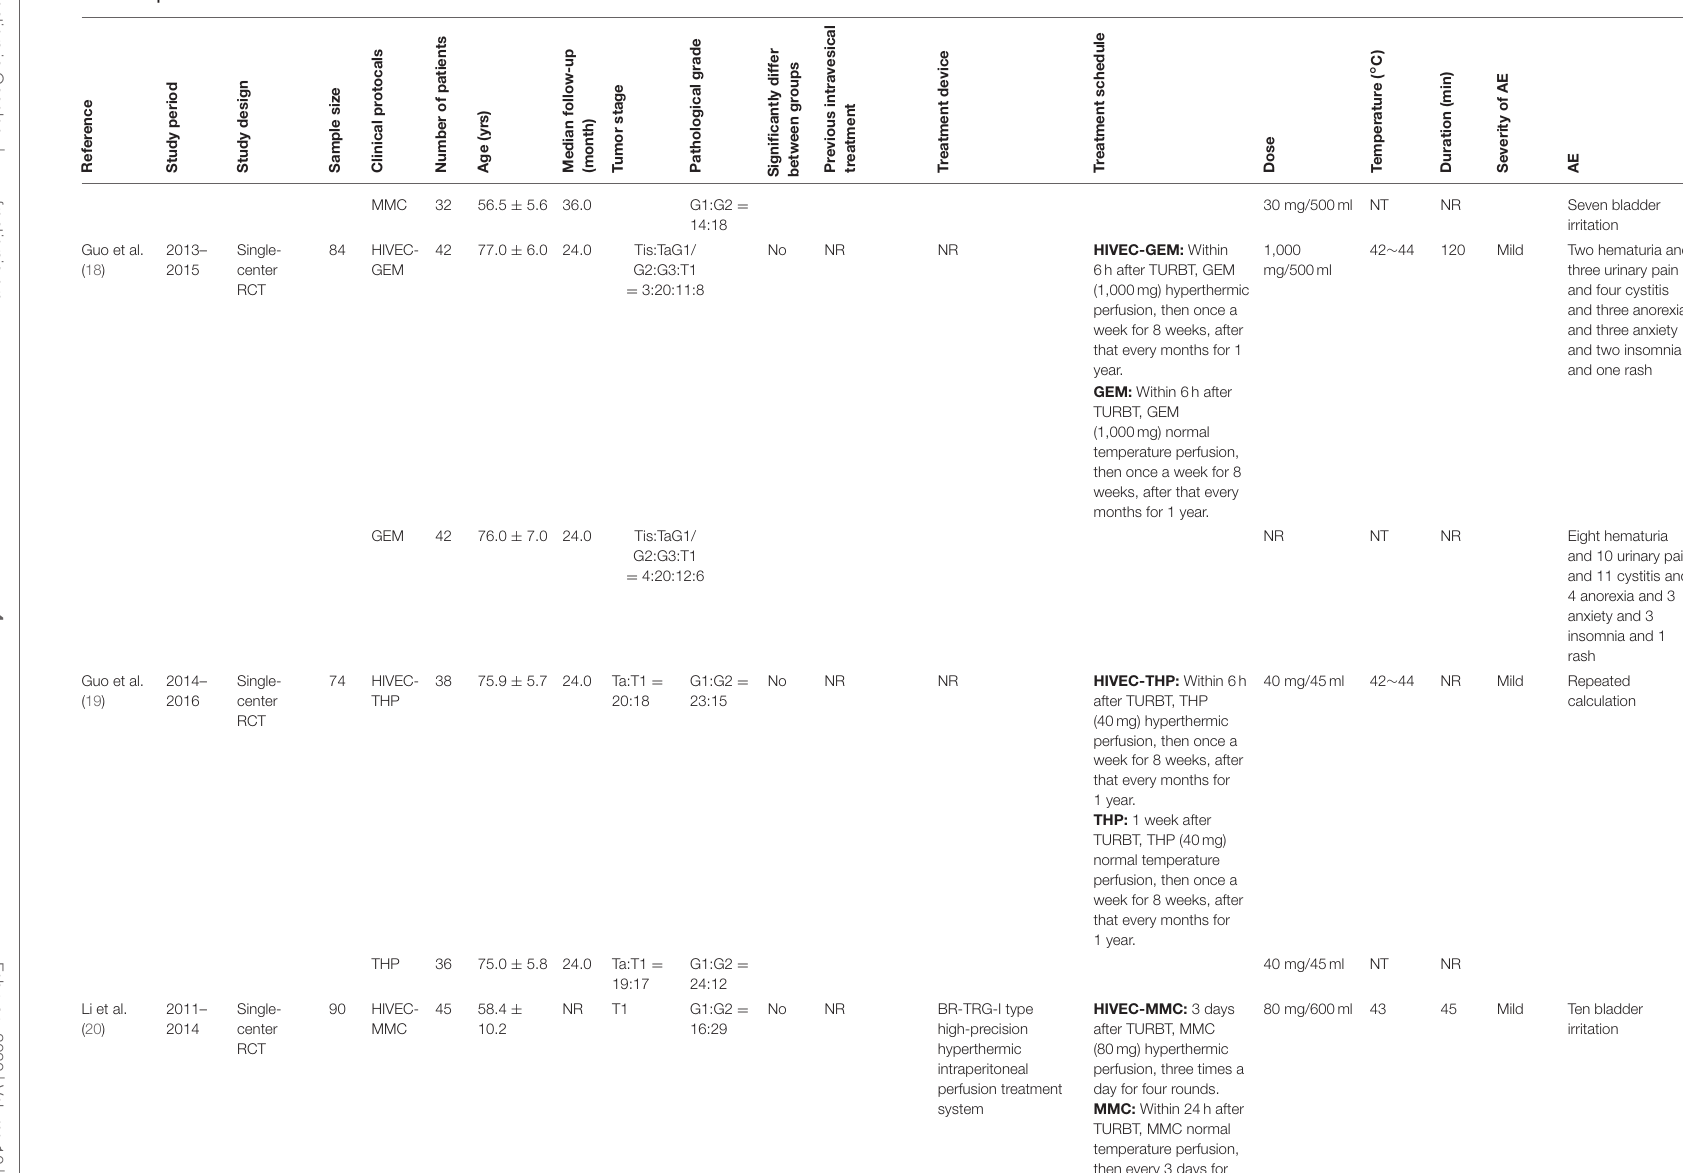
BR-TRG-I type high-precision hyperthermic intraperitoneal perfusion treatment system